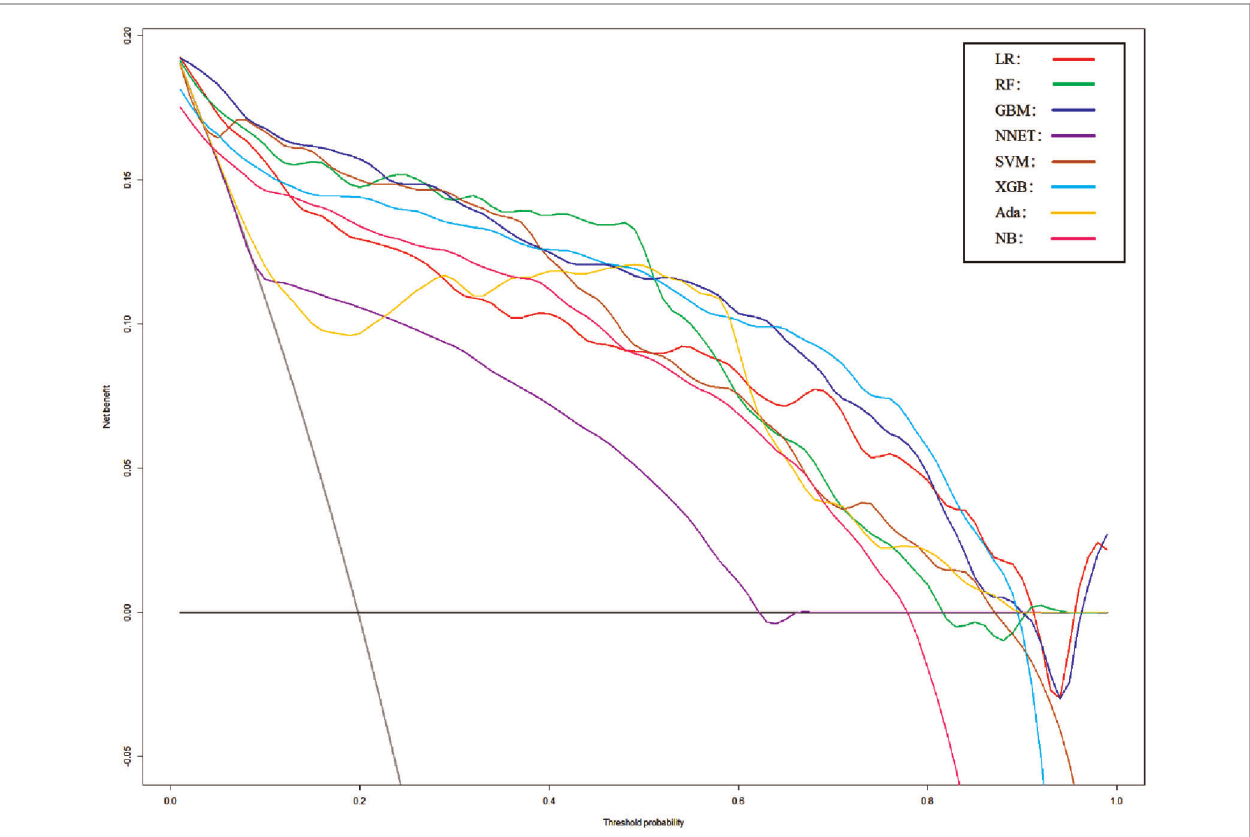
FIGURE 6 | Decision curve analysis of Model2. LR, logistic regression; RF, random forest; GBM, gradient boosting machine; NNET, arti fi cial neural network; SVM, support vector machine; XGB, eXtreme gradient boosting; Ada, adapting boosting; NB, naïve Bayes; Model2 was adjusted for GCS, glucose, sodium, chloride, SPO 2 , bicarbonate, temperature, white blood cell (WBC), heparin use, SOFA score, creatinine, bun, platelet, age, marital, trauma, lymphocytes, calcium, race, and cerebrovascular